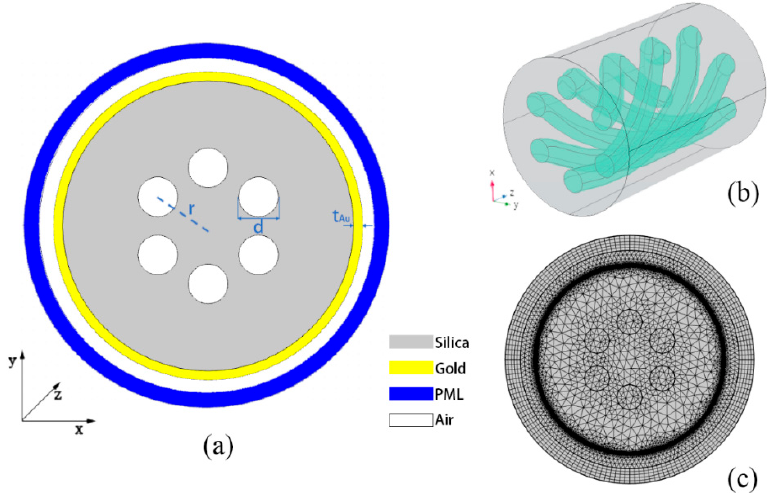
Figure 1. ( a ) Schematic diagram of the designed HMSF; ( b ) 3D structure diagram of the HMSF; ( c ) fiber diagram with a meshing grid.